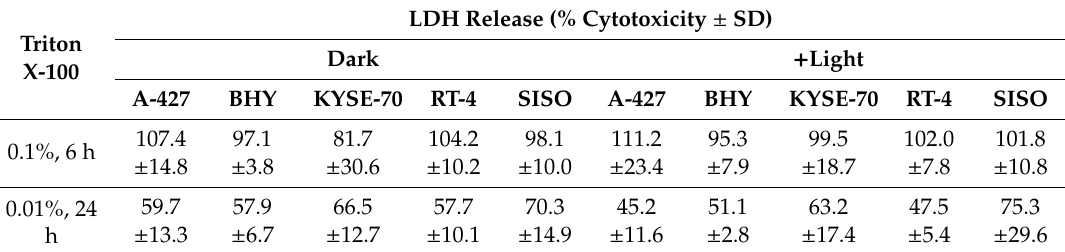
Table 2. Established % cytotoxicity as assessed by lactate dehydrogenase (LDH) release assay after treatment of cells with 0.1% ( v / v , 6 h) and 0.01% ( v / v , 24 h) Triton X-100 positive control after incubation in the dark and post illumination with a light dose of 1.8 J / cm 2 (24 h) or 3.5 J / cm 2 (6 h), respectively. Results as means ± SD from at least three independent